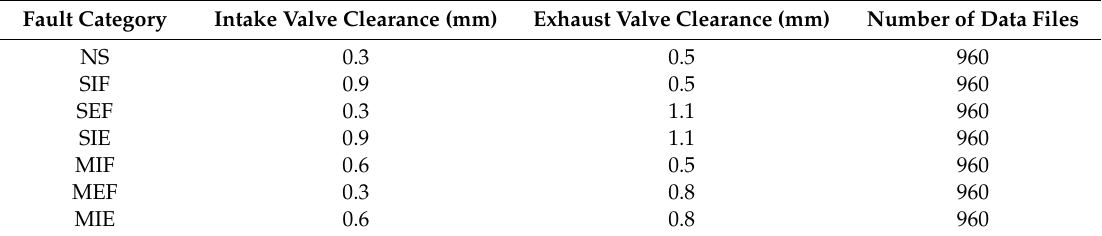
Figure 6. Valve train and the main test rig components: ( a ) intake valve and exhaust valve and ( b ) the sketch of diesel engine test rig and sensors positioning. Table 2. The detailed fault valve train clearance setting.